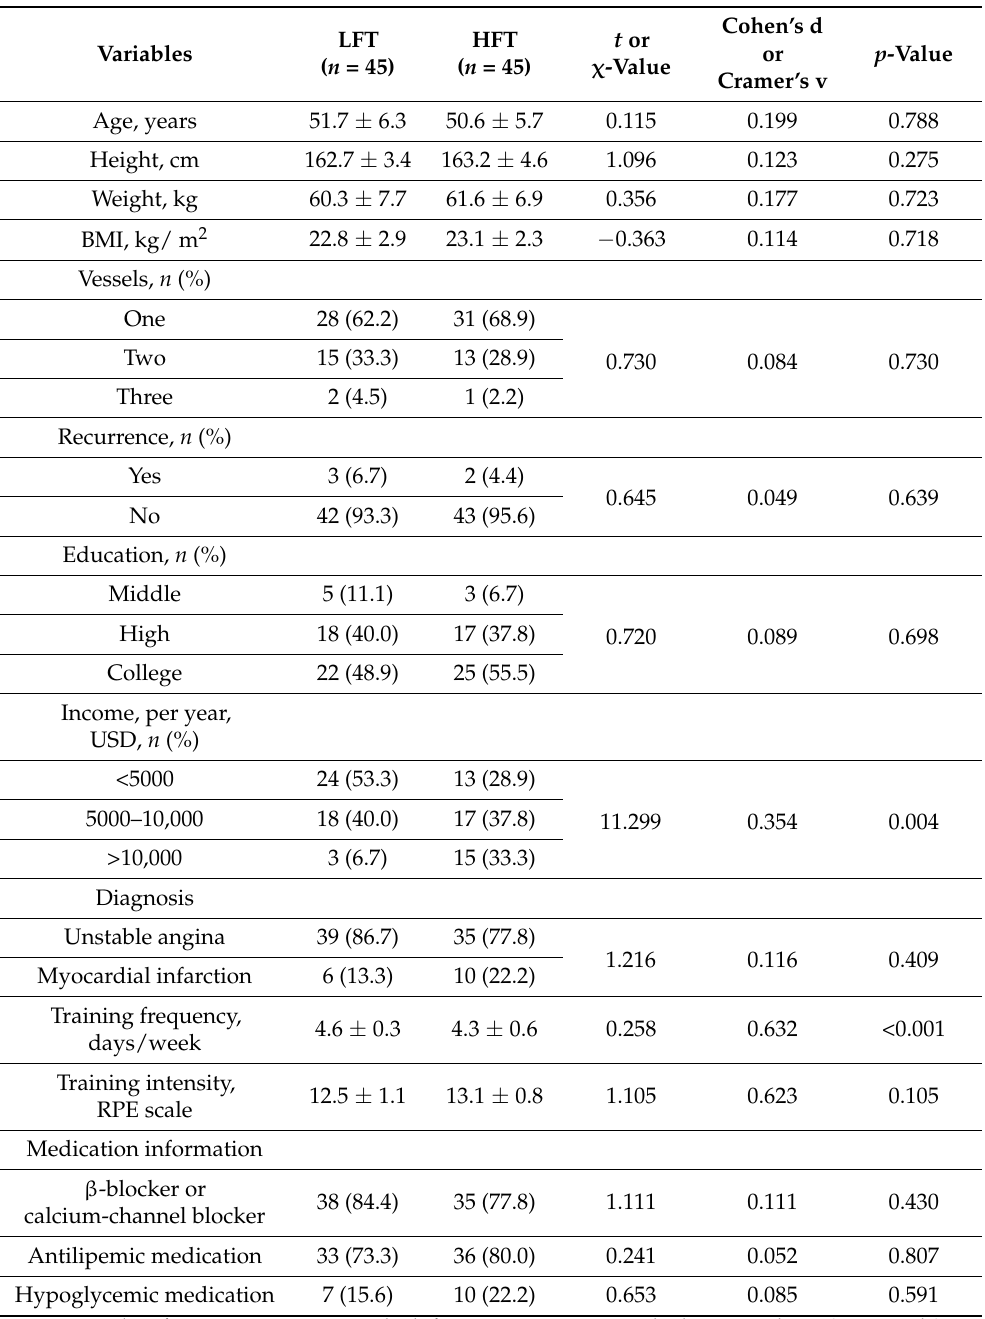
Table 1. Characteristics of participants according to CR attendance